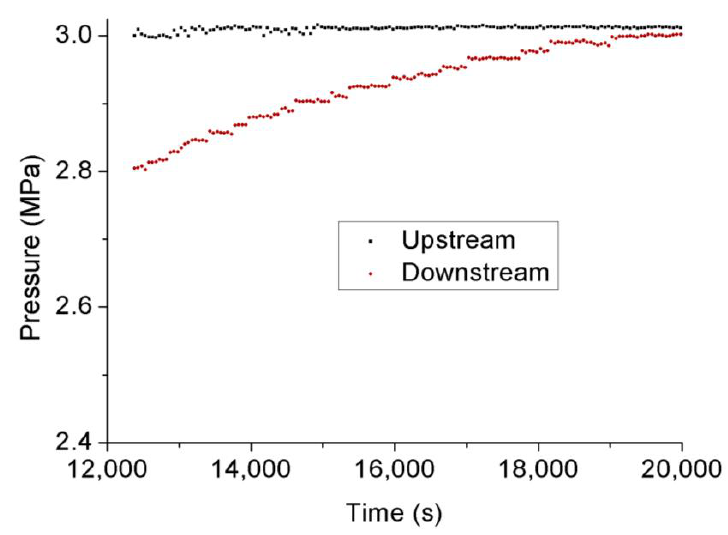
Figure 20. Development of downstream pressure with time at 3 MPa injection pressure under 20 MPa confinement.